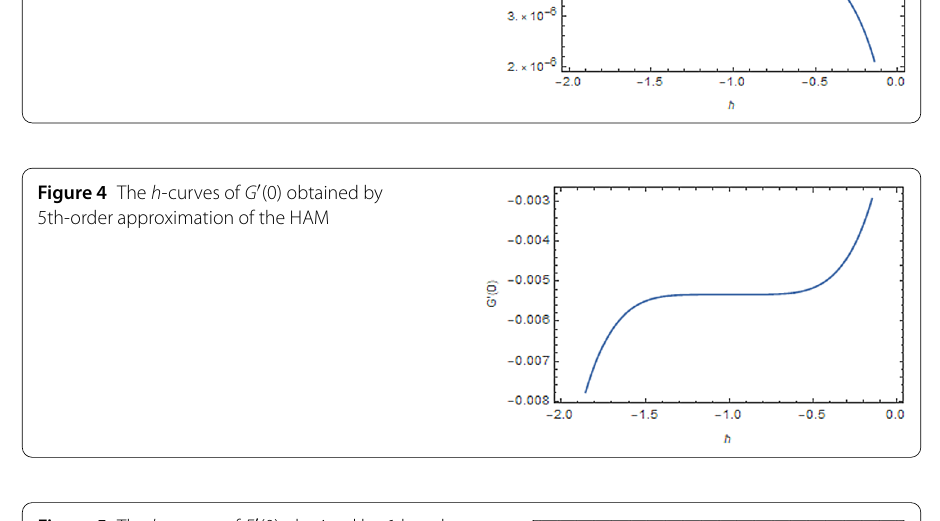
Figure 5 The h -curves of E (cid:10) (0) obtained by 6th-order approximation of the HAM